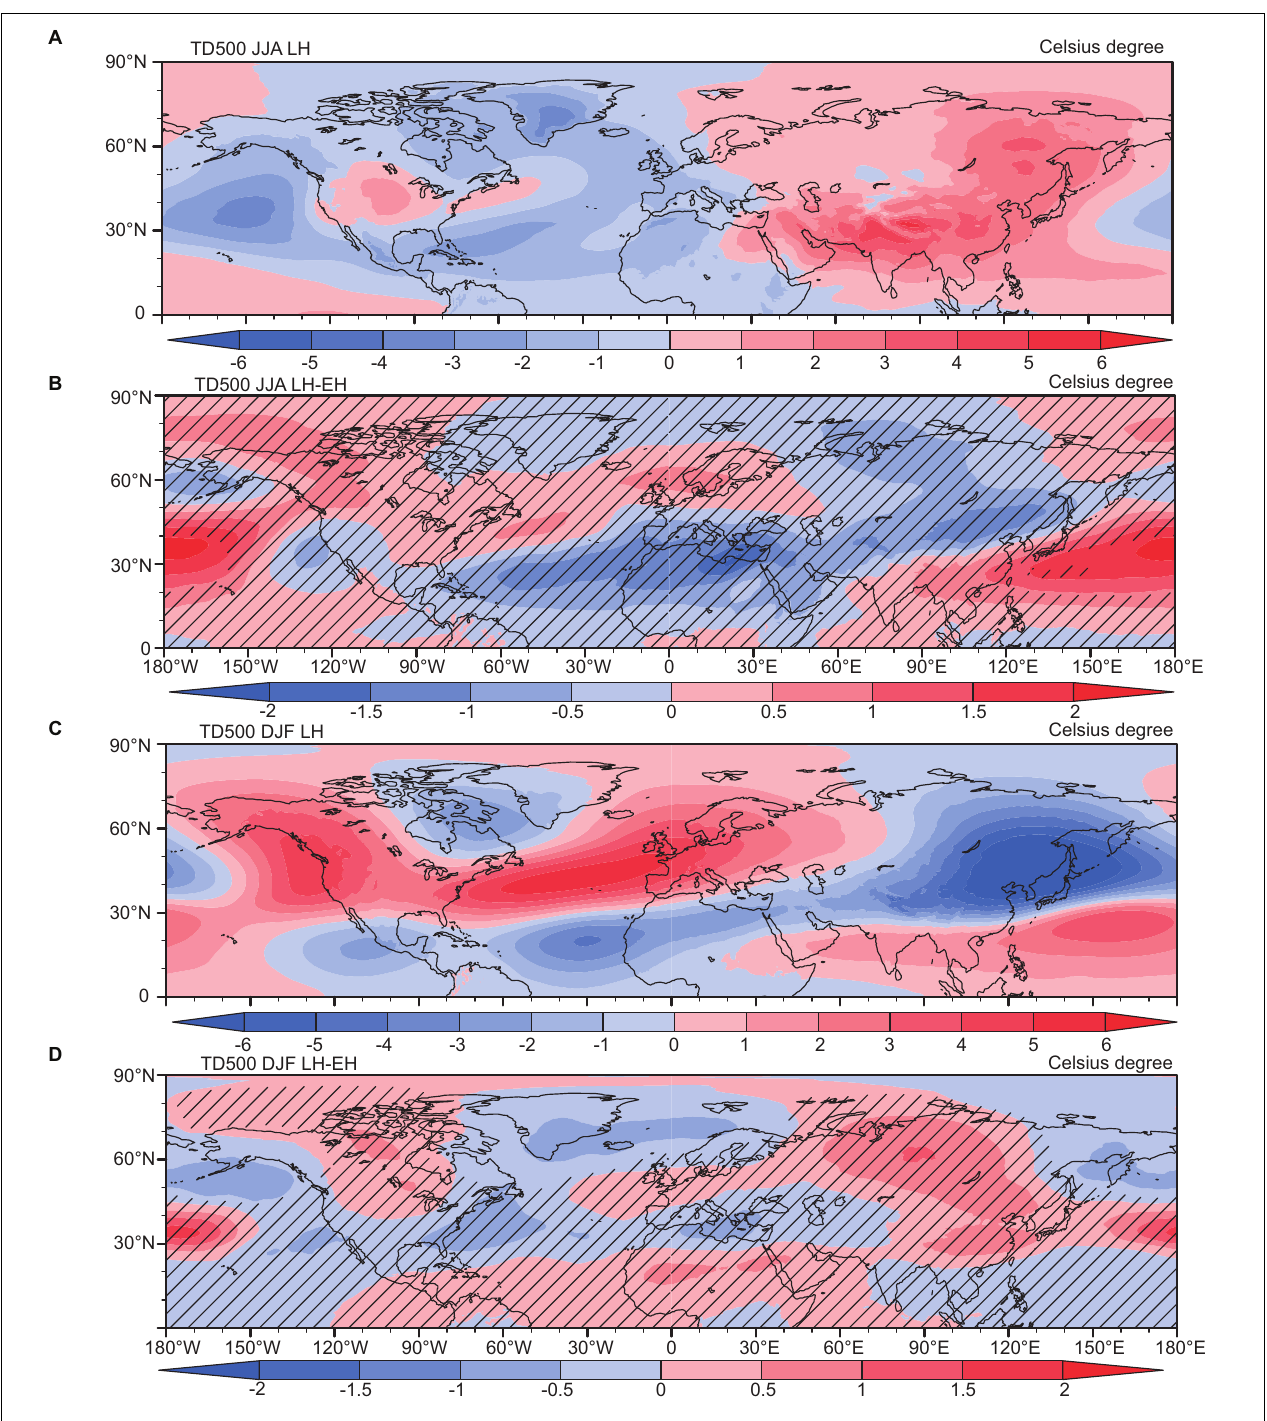
FIGURE 8 | The 500 hPa temperature disturbance over the Northern Hemisphere during the Holocene. Summer and winter 500 hPa temperature disturbance in LH (A,C) and the LH-minus-EH difference (B,D) . The line indicates the differences at the 95% significance level.